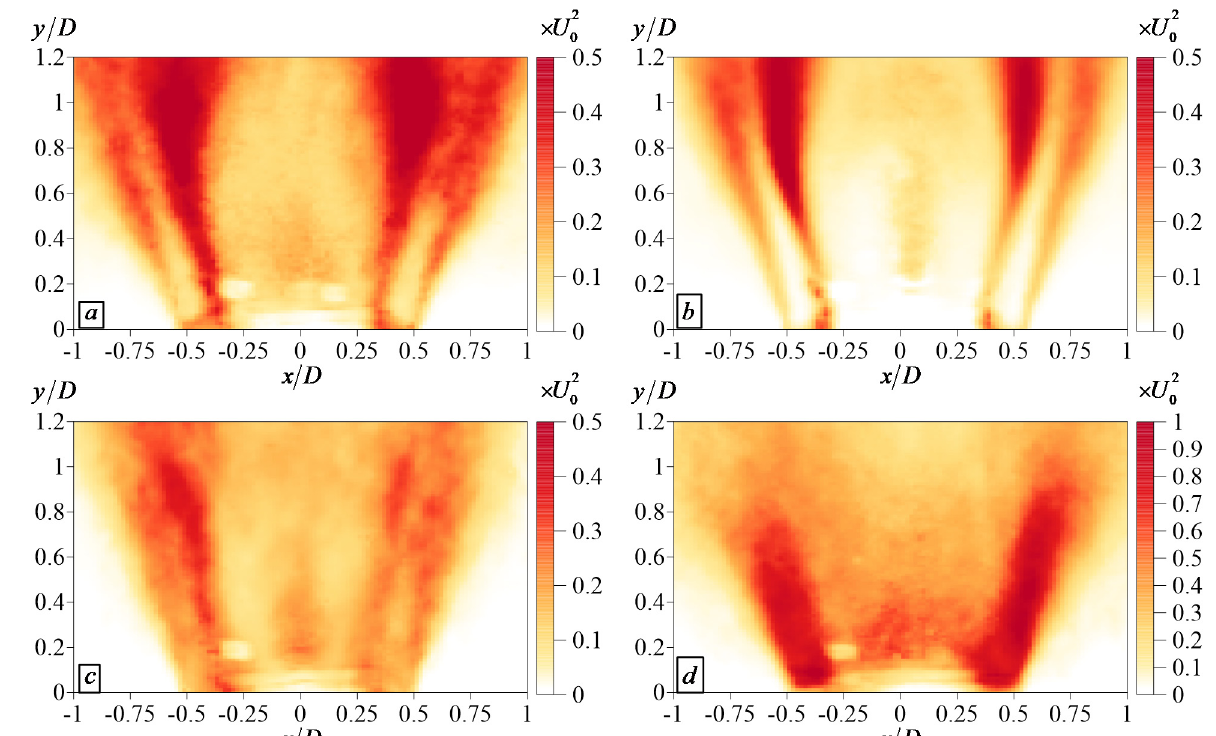
Figure 4. Variance of the longitudinal velocity component for methane ( a , c ) and syngas ( b , d ) flames at normal conditions ( a , b ) and elevated pressure and temperature ( c , d ).